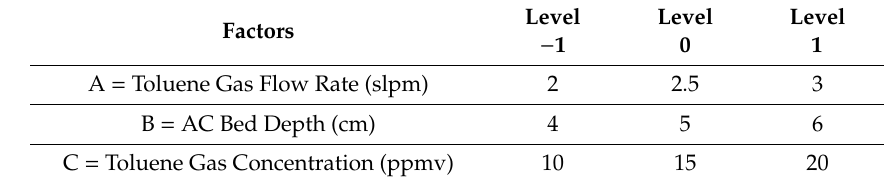
Table 1. Factors and their levels for toluene adsorption response surface methodology (RSM) modeling. Factors